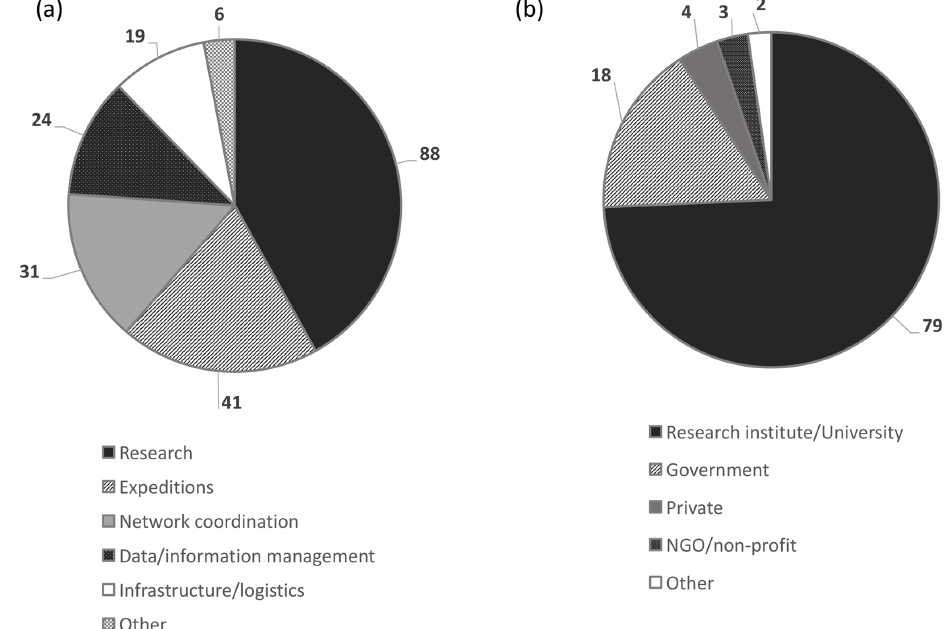
Figure 4. Distribution of project (a) and organization (b) types among respondents group.